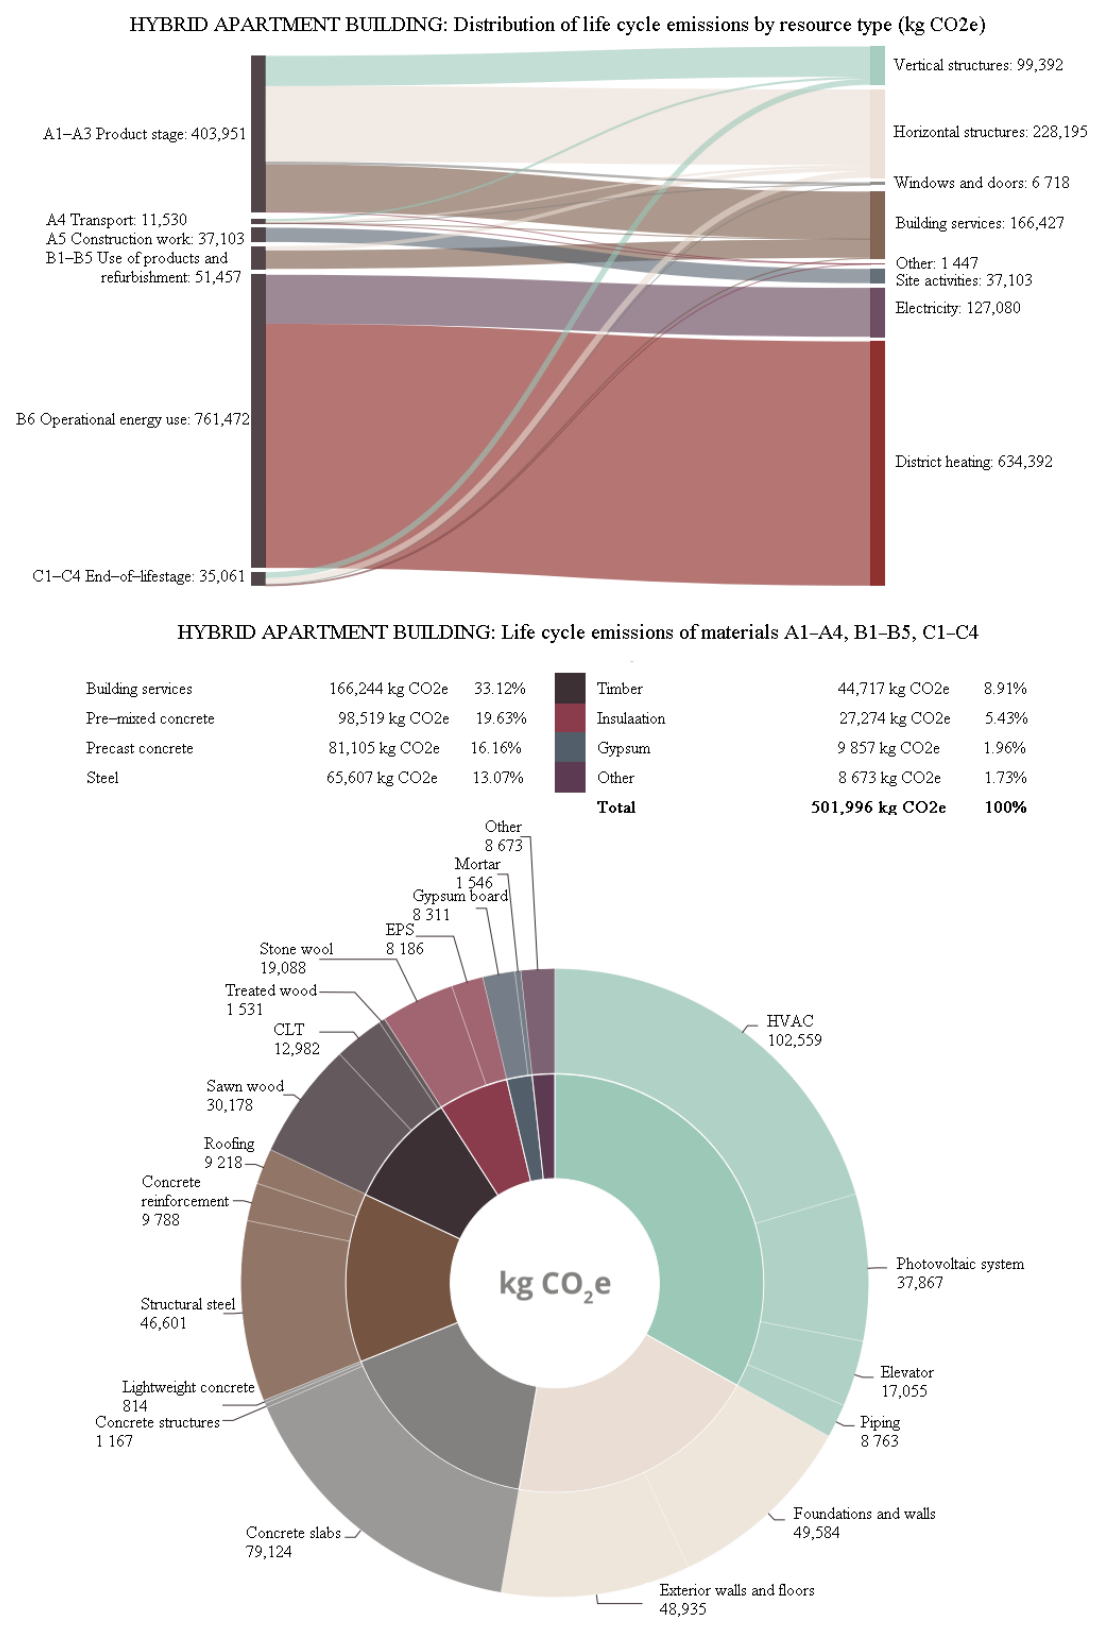
Figure 13. Distribution of the carbon footprint of the hybrid apartment building.